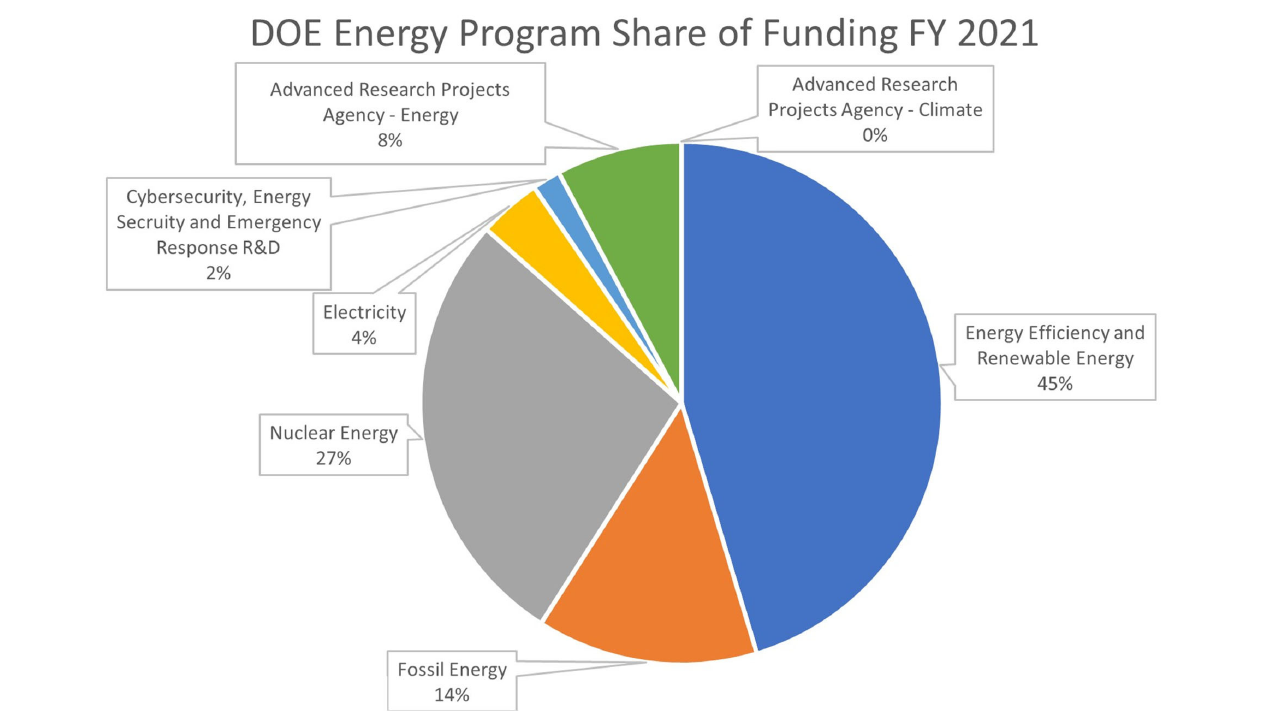
FIGURE 2 | The share of funding for the U.S. Department of Energy’s (DOE) spending for fiscal year (FY) 2021 in energy research and development programs. Percentages generated from data retrieved from Congressional Research Service’s Federal Research and Development Funding: FY2022 report, R46869 ( Sargent, 2021